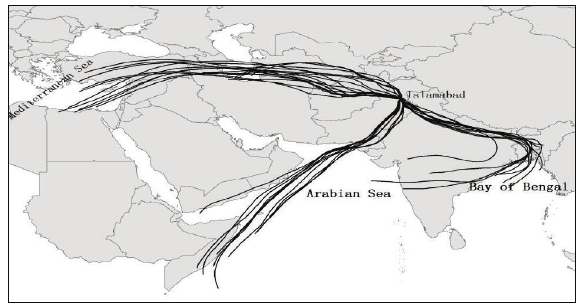
Figure 4: Back trajectories of air masses of Islamabad (33.65 ∘ N, 73.26 ∘